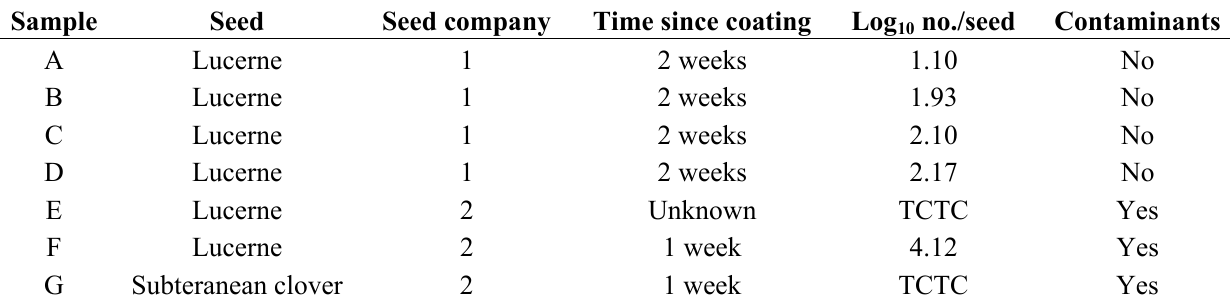
Table 1. Number of viable rhizobia/seed on seed inoculated using commercial processes. Samples were collected from small experimental batches except sample E which was a commercial batch. TCTC = too contaminated to